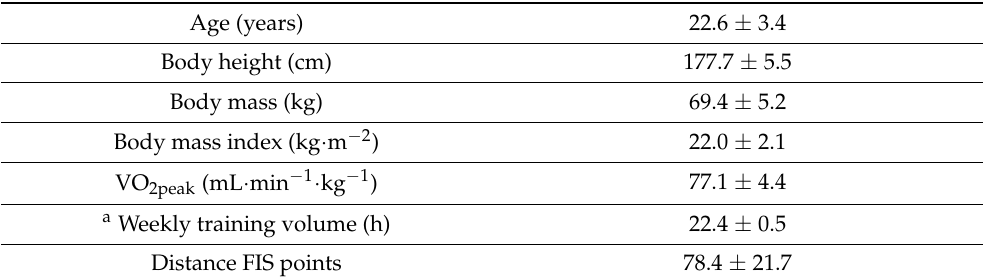
Table 1. Participant characteristics of the fourteen national-level male cross-country skiers participat- ing in the